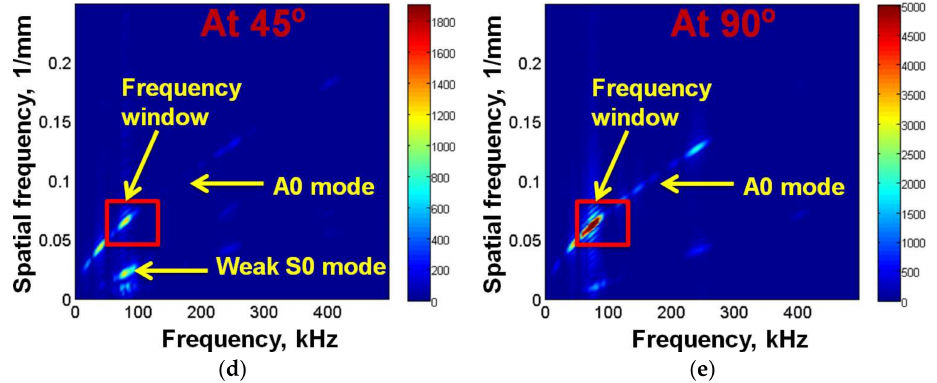
Figure 8. Experimental analysis and post-processing: Experimental set-up showing the glued MFC on Al alloy plate and the initial position of a point-type contact transducer (dimensions are not in scale) connected with LF ultrasonic system ( a ), showing the scanning process to acquire 19 B-scans at each 5 ◦ in the angular direction from 0 ◦ to 90 ◦ ( b ), showing the application of frequency window on the dispersion curves of the first (at 0 ◦ ), tenth (at 45 ◦ ) and nineteenth (at 90 ◦ ) B-scans for selecting the appropriate signals at excitation frequency of 80 kHz ( c – e